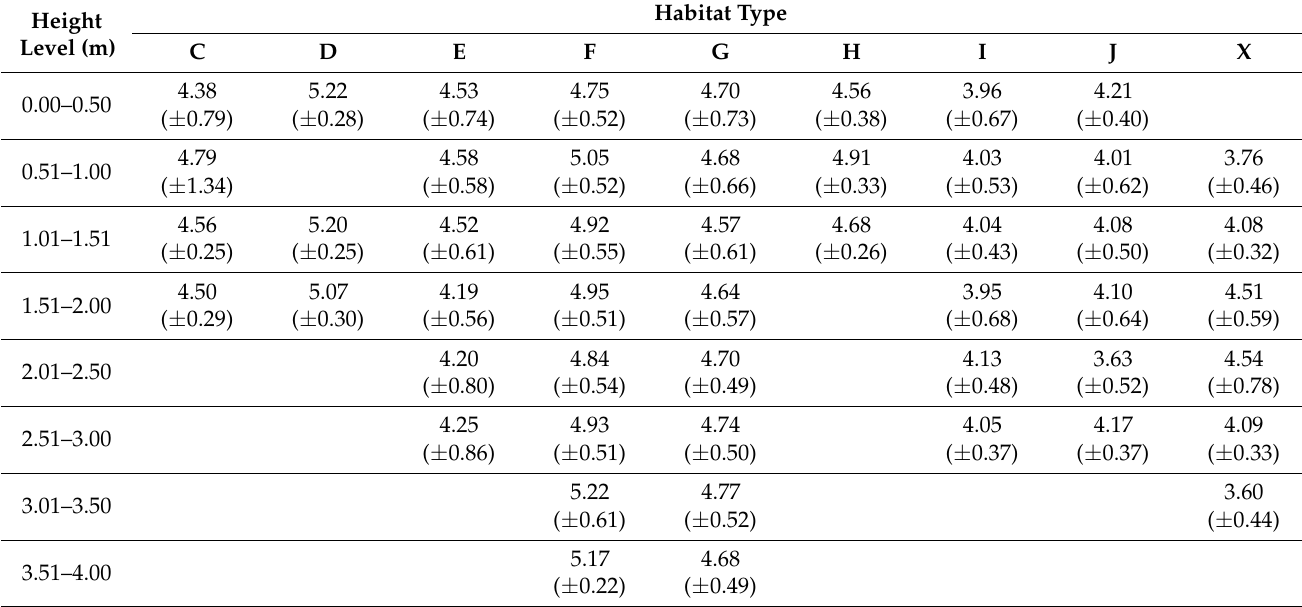
Table 6. The length (cm) of the fruits(mean ± SD) of Echinocystis lobata at different height levels in inland surface waters (C); mires, bogs, and fens (D); grasslands and lands dominated by forbs, mosses, or lichens (E); heathland, scrub, and tundra (F); woodland, forest, and other wooded land (G); inland unvegetated or sparsely vegetated habitats (H); regularly or recently cultivated agricultural, horticultural, and domestic habitats (I); constructed, industrial, and other artificial habitats (J); habitat complexes